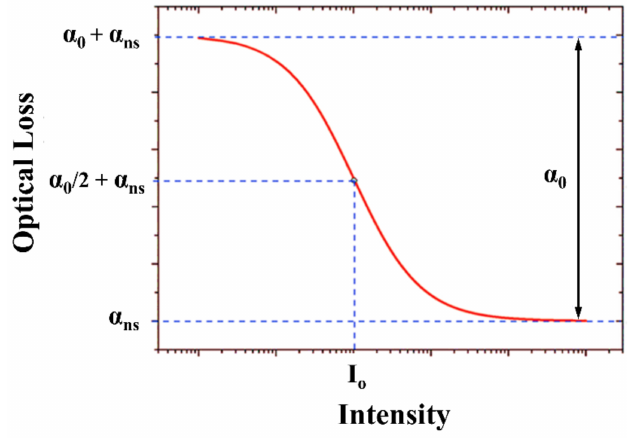
Figure 1. Saturable absorption curve with parameters for